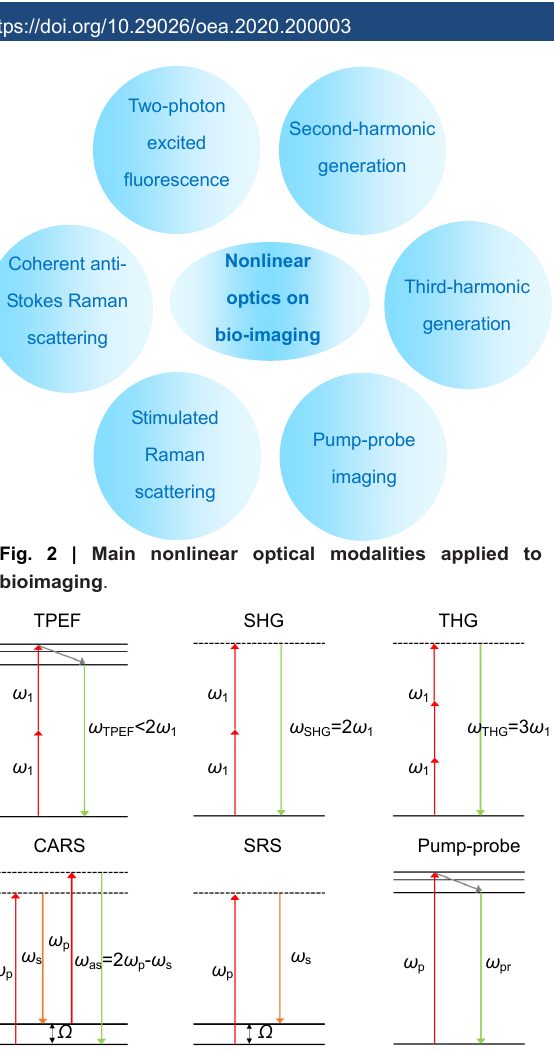
Fig. 3 | Energy diagrams of nonlinear optical processes em- ployed for the bio-imaging. TPEF: two-photon excited fluores- cence. In this process, the material is excited by two photons with frequency of ω 1 and emits a photon ( ω TPEF ) with higher energy than each incident photon. SHG: second-harmonic generation. In this process, two photons with frequency of ω 1 are converted to one photon ( ω SHG ) with energy doubled of the incident photon. THG: third-harmonic generation. In this process, three photons are converted to one photon ( ω THG ) with energy triple of the inci- dent photon. CARS: coherent anti-Stokes Raman scattering. In this process, pump beam with frequency of ω p and Stokes beam with frequency of ω s interact with the material and generate a signal at anti-Stokes frequency ω as =2 ω p - ω s . The signal can be enhanced when Ω = ω p - ω s is close to the frequency of a vibrational energy state of a chemical bond in the sample. SRS: stimulated Raman scattering. In this process, when the frequency difference of pump beam and stokes beam Ω , matches the vibrational reso- nance, a small part of the input energy transfers from one beam to the other. Pump-probe: in this process, a transient absorption is induced by the pump beam ( ω p ) and change the excited state of the material first. Then such change is detected by a probe beam ( ω pr ), and the dynamics of excited state can be deduced through varying the delay time between probe and pump beam pulses. The solid lines are the electronic and vibrational states, and the dashed lines are the virtual states.